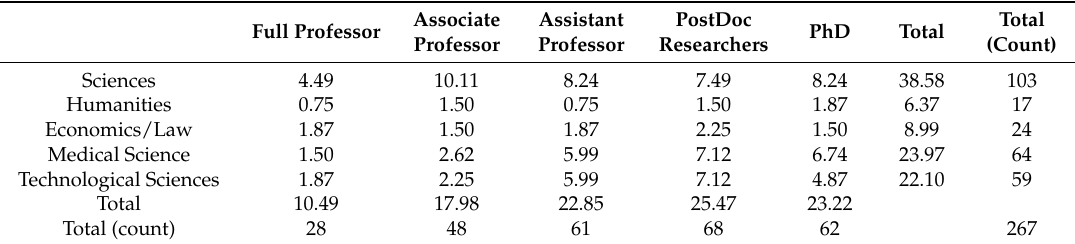
Table 1. Respondents distribution (shares).